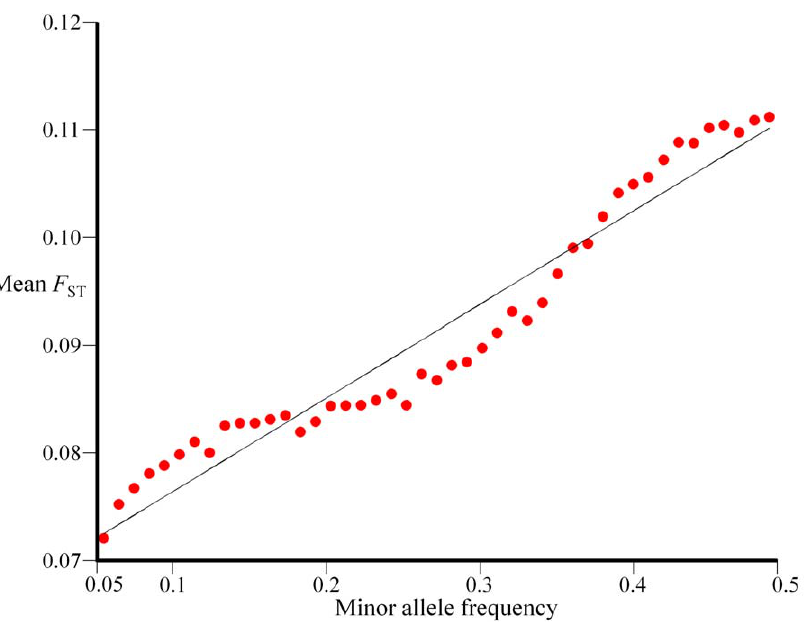
Figure 6. Correlating MAF with F ST . The mean F ST plotted for all MAF groups (dots), excluding the rarest ones (MAF . 0.05), allows us to express the correlation between the two variables using a single linear equation (Eq. 4).